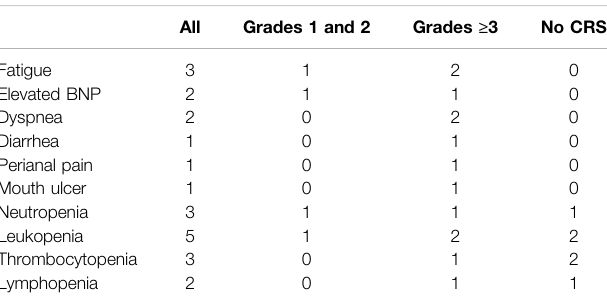
TABLE 4 | Number of the patients of the adverse event. All Grades 1 and